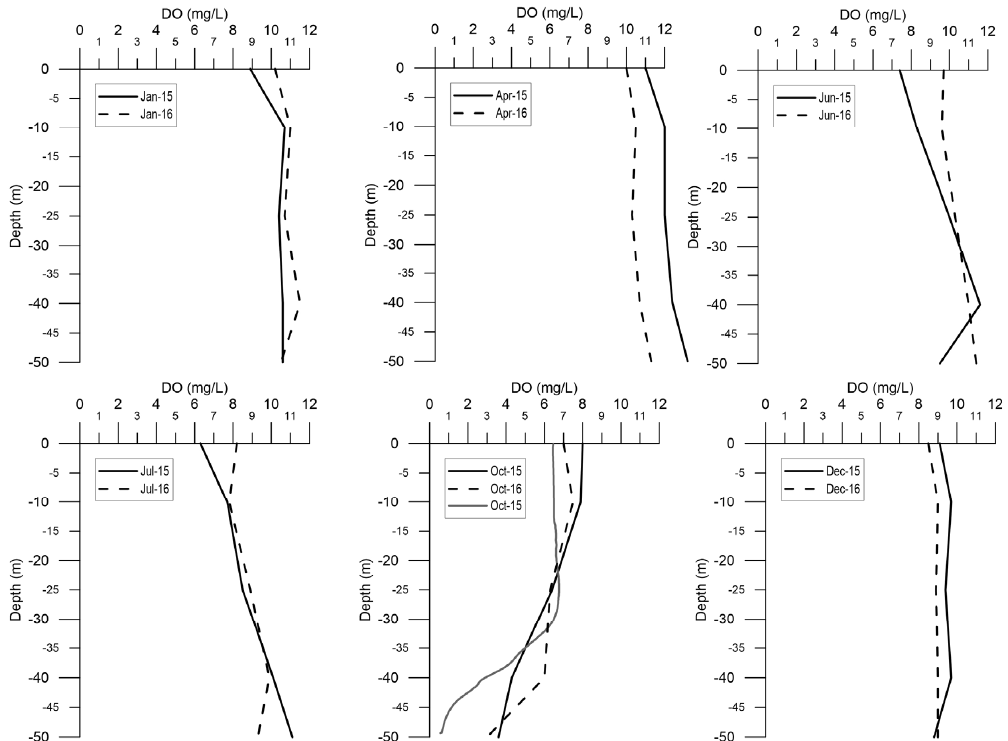
Figure 6. Dissolved oxygen (DO, mg/L) distribution along the water column in 2015 and 2016 for each monitoring campaign (6 per year). The grey line on the October graph indicates data collected continuously along the water column, down to the reservoir bottom, by the CTD probe.